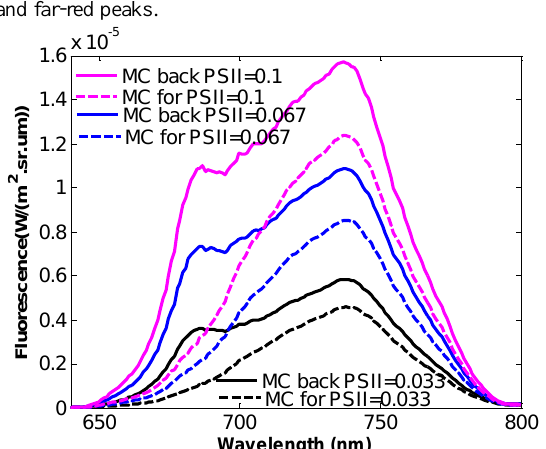
Figure 6. Simulated leaf backward (MC back) and forward (MC for) fluorescence by the MC model with Φ PSII of 0.033, 0.067, and 0.1